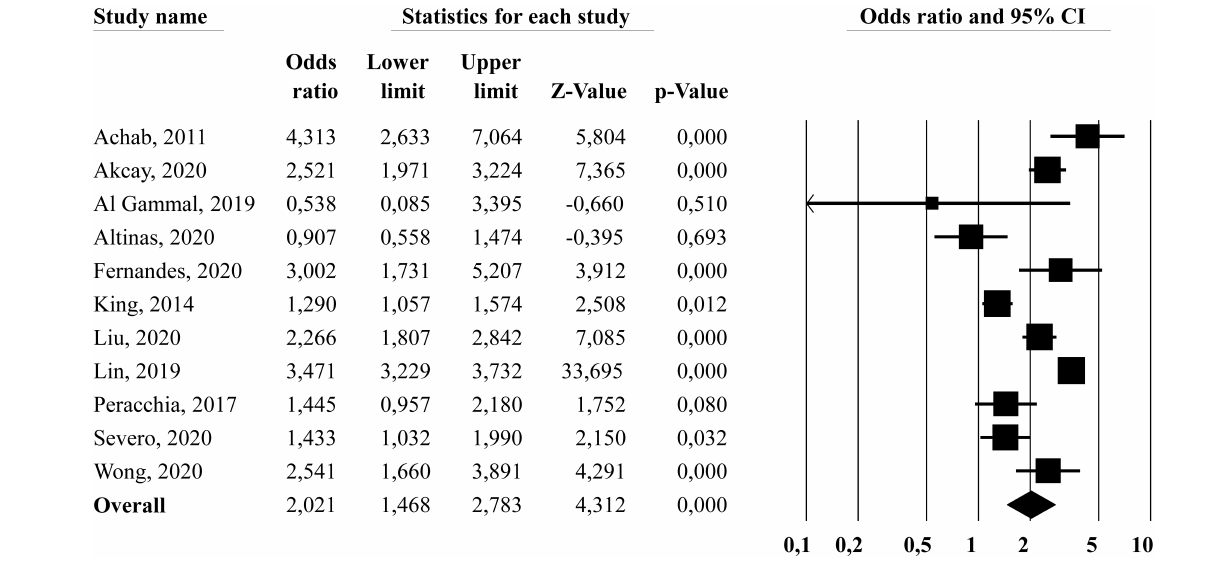
of true between-study variance ( I 2 = 88.5%). The subgroup analysis comparing studies targeting adolescent populations ( k = 8, weighted mean age = 15.0) and studies targeting adult/non- specific age populations ( k = 7, weighted mean age = 24.6) did not yield any significant differences between subgroups ( Q bet = 0.61, df = 1, p = 0.434). There was significant heterogeneity within the adolescent subgroup ( Q = 115.45, df = 7, p < 0.001, I 2 = 93.9%) while there was no significant heterogeneity within the adult/non-specific group ( Q = 6.13, df = 6, p = 0.409, I 2 = 2.1%). Finally, the subgroup analysis comparing studies that used a single-item sleep measure ( k = 6) and studies using multi-item